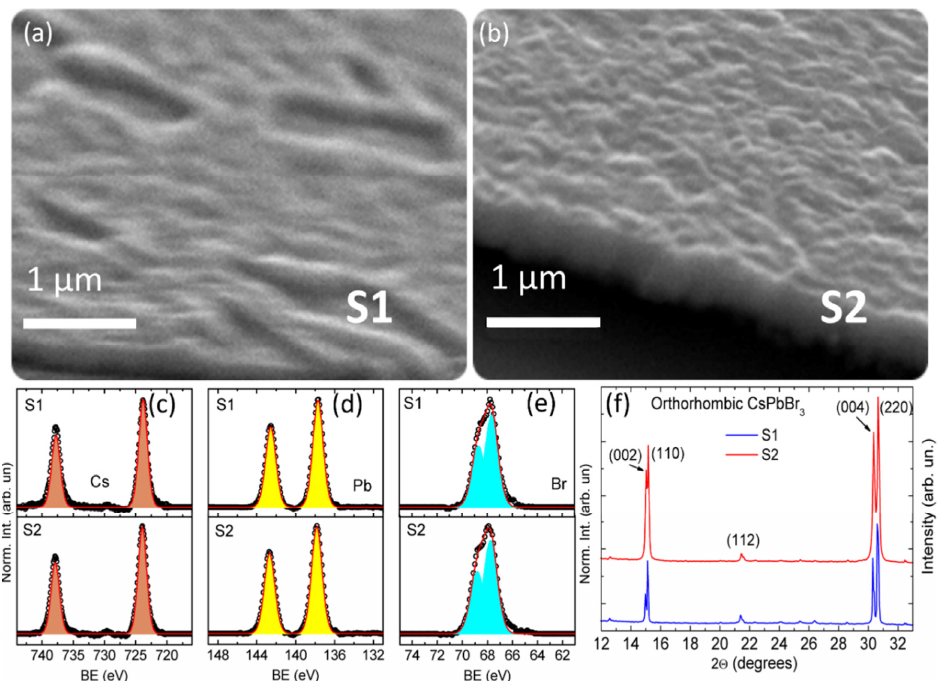
Figure 1. ( a ) SEM micrograph of a random area of sample S1. The formation of micro-sized super- structures and valleys is shown. ( b ) SEM micrograph of a random area of sample S2 (with corrected target composition), showing a flat and uniform film, differentiating S2 from S1. ( c – e ) XPS high- resolution spectra of S1 (top) and S2 (bottom), from left to right the regions of cesium, lead and bromide are reported. ( f ) XRD patterns of samples S1 and S2, showing good agreement with the orthorhombic phase of CsPbBr 3 for both.